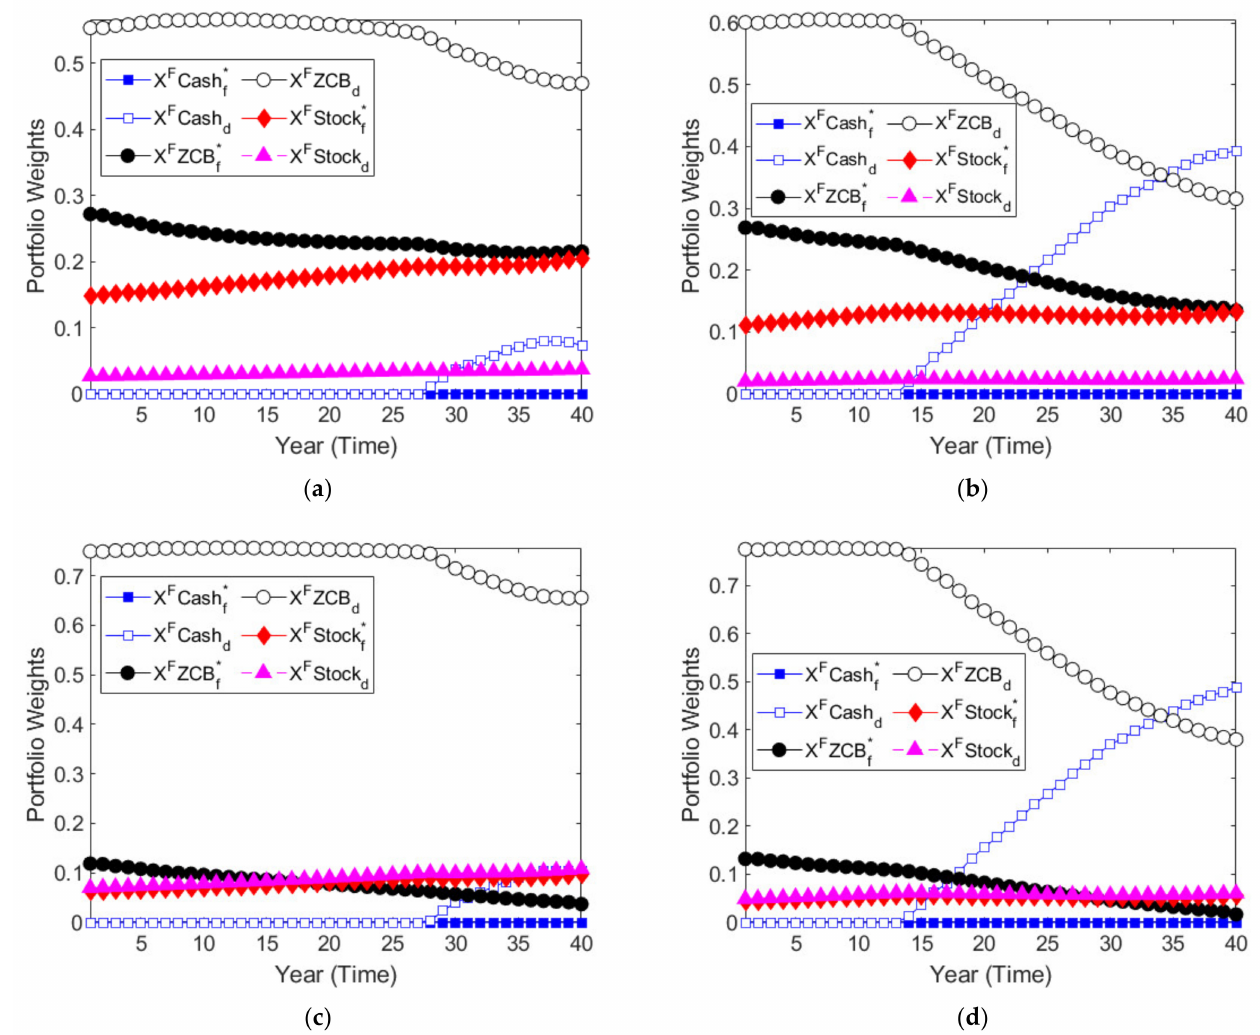
Figure 3. Optimal proportions of pension portfolio assets with short sales and leverage